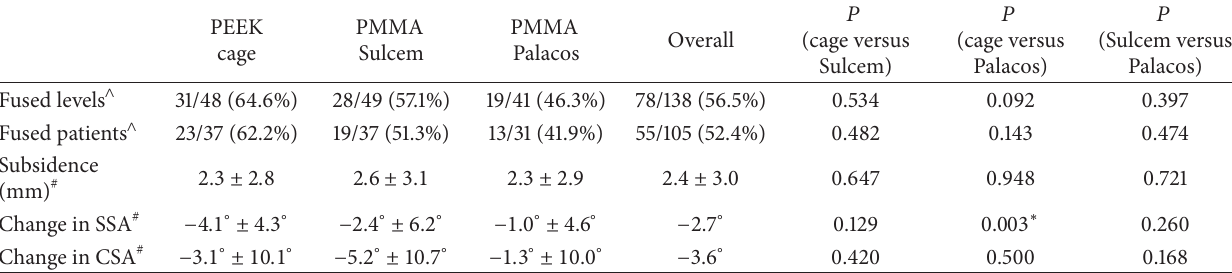
Table 2: Bony fusion, subsidence, and sagittal alignment.